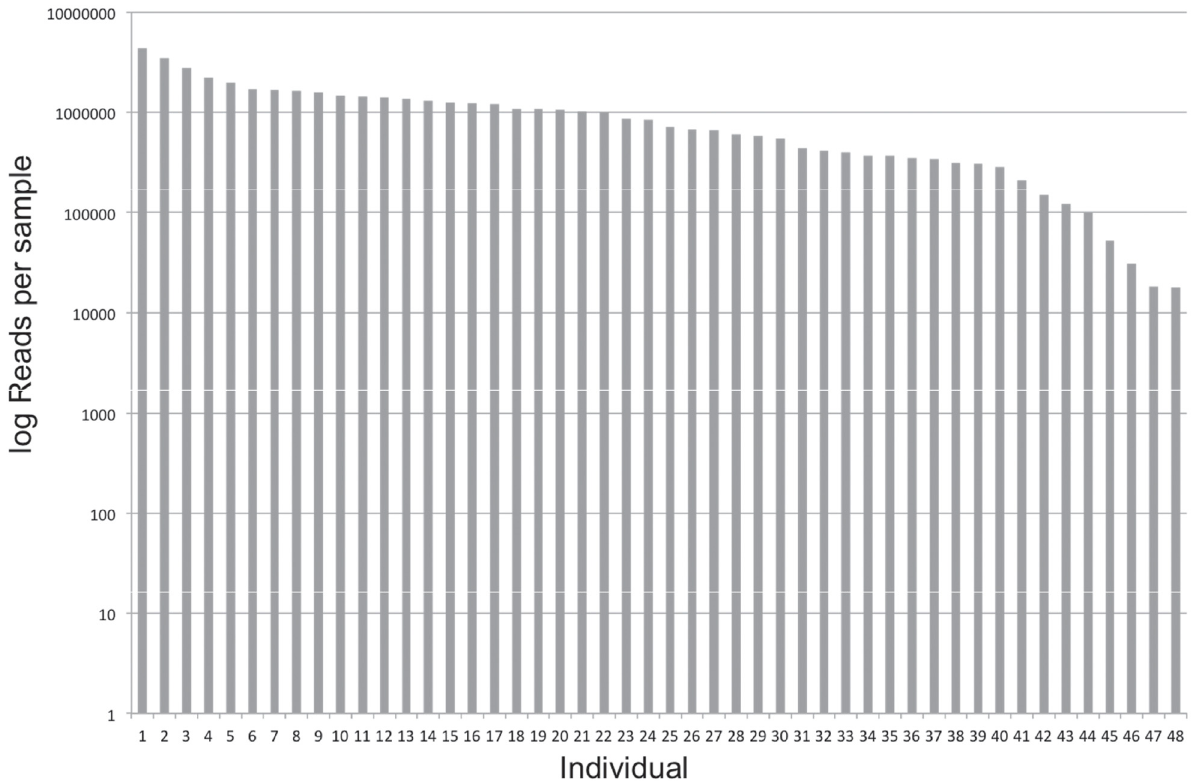
Fig 3. Number of reads per sample mapped back to the Eucalyptus grandis targets, sorted from high to low.